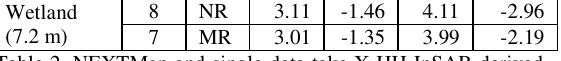
Table 2. NEXTMap and single-data take X-HH InSAR-derived h spc error assessment against in situ vegetation canopy height for the International Falls site, stratified by vegetation cover type and incidence angle range for <10 º terrain slope.